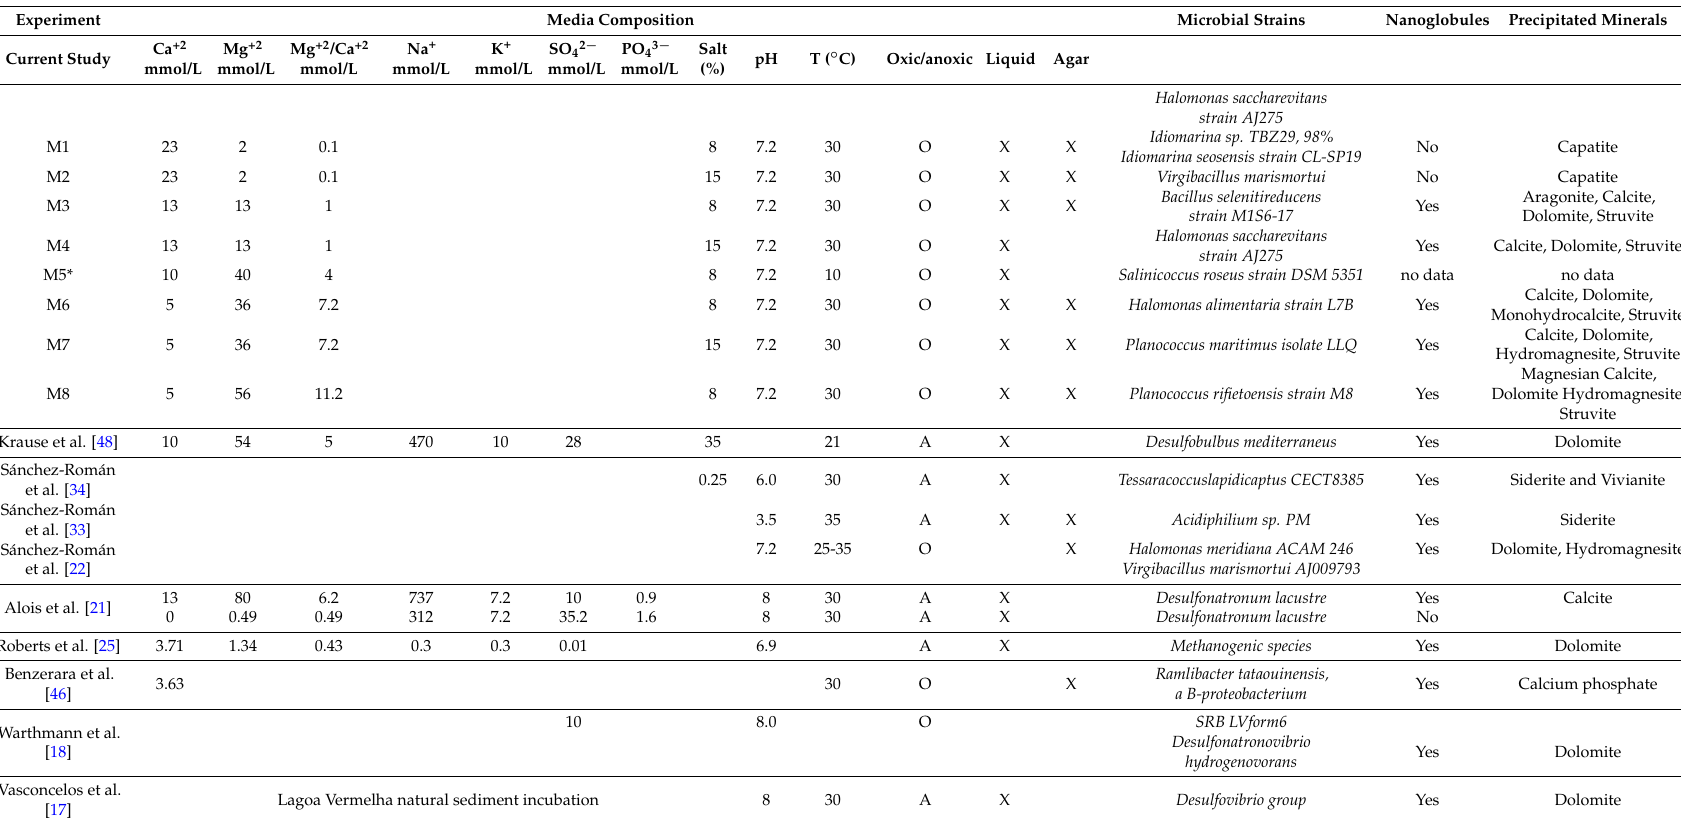
Table 5. Compilation of previous studies reported formation of nanoglobules under various experimental